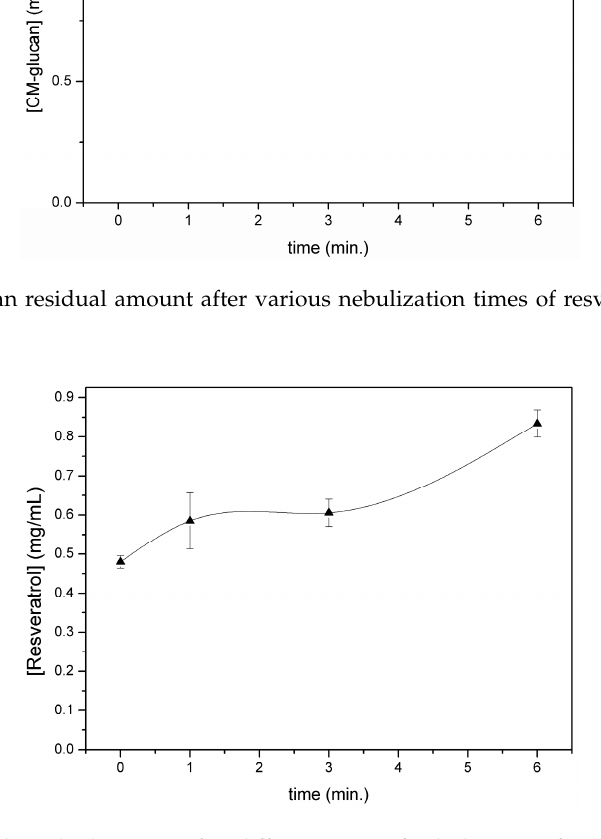
Figure 5. Resveratrol residual amount after different times of nebulization of resveratrol/CM-glucan formulation.